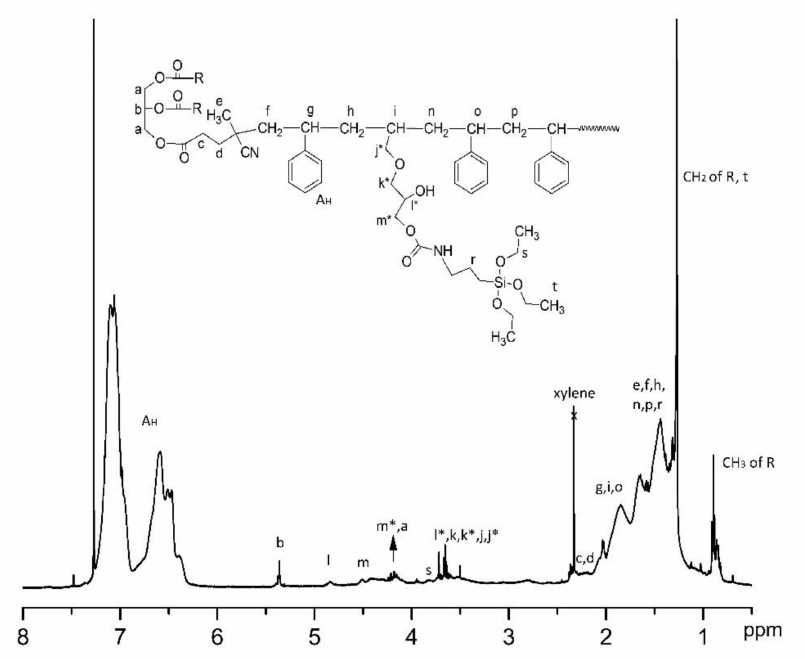
Figure 7. 1 H NMR spectrum of the